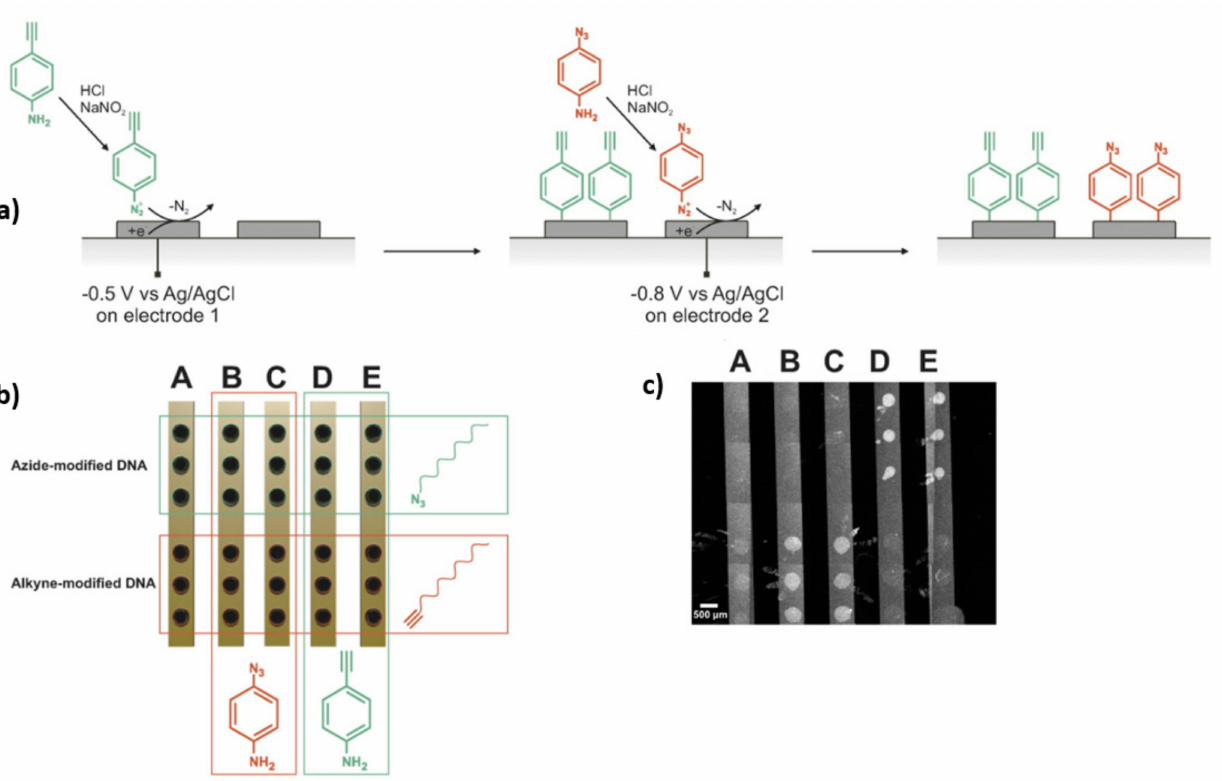
Figure 6. Schematic representation of the strategy employed for site-specific immobilization of two different ssDNA probes on a single chip: ( a ) site-specific electrografting of ethynylphenyl and azidophenyl groups on adjacent Au electrodes; ( b ) pattern for selective immobilization of azide- and alkyne-modified ssDNA: electrode A was not grafted and served as a reference, electrodes B and C were grafted with azidophenyl and electrodes D and E with ethynylphenyl groups, respectively; ( c ) fluorescence microscopy images taken after hybridization of immobilized ssDNA probes with Cy3 dye- labeled complementary DNA. Reprinted with permission from [38]. Copyright 2016